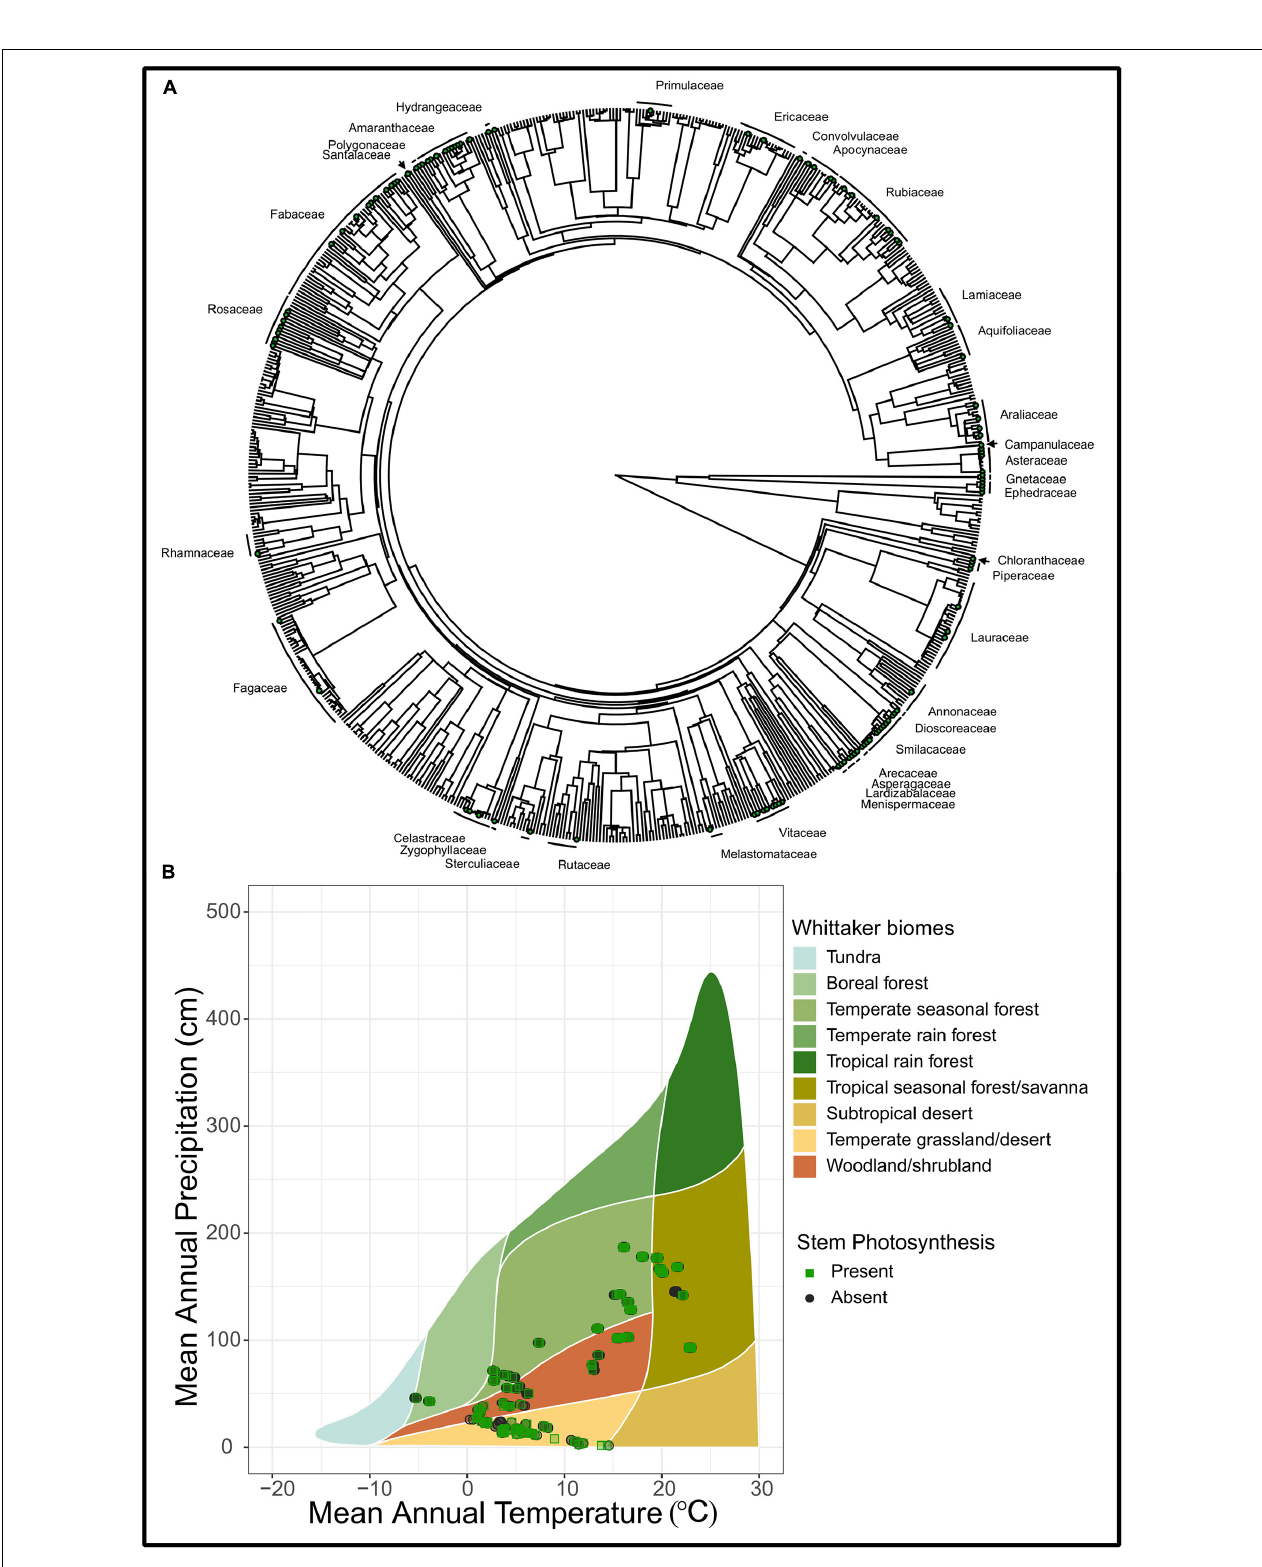
FIGURE 2 | (A) A phylogenetic tree of 685 species from Prentice et al. (2011) and Wang et al. (2018) that demonstrate stem photosynthesis. Green points represent species with stem photosynthesis and families that have at least a single species are labeled on the outside of the tree. (B) A Whittaker plot illustrating the climatic space of stem photosynthesis. Shown are observations where stem photosynthesis was recorded as present (“Present”) and those where stem photosynthesis was recorded as absent (“Absent”). Out of a total of 719 species in this plot, stem photosynthesis was present in 125 species and absent in 594 species. Observations were plotted as semi-transparent points in order to improve clarity of clustered